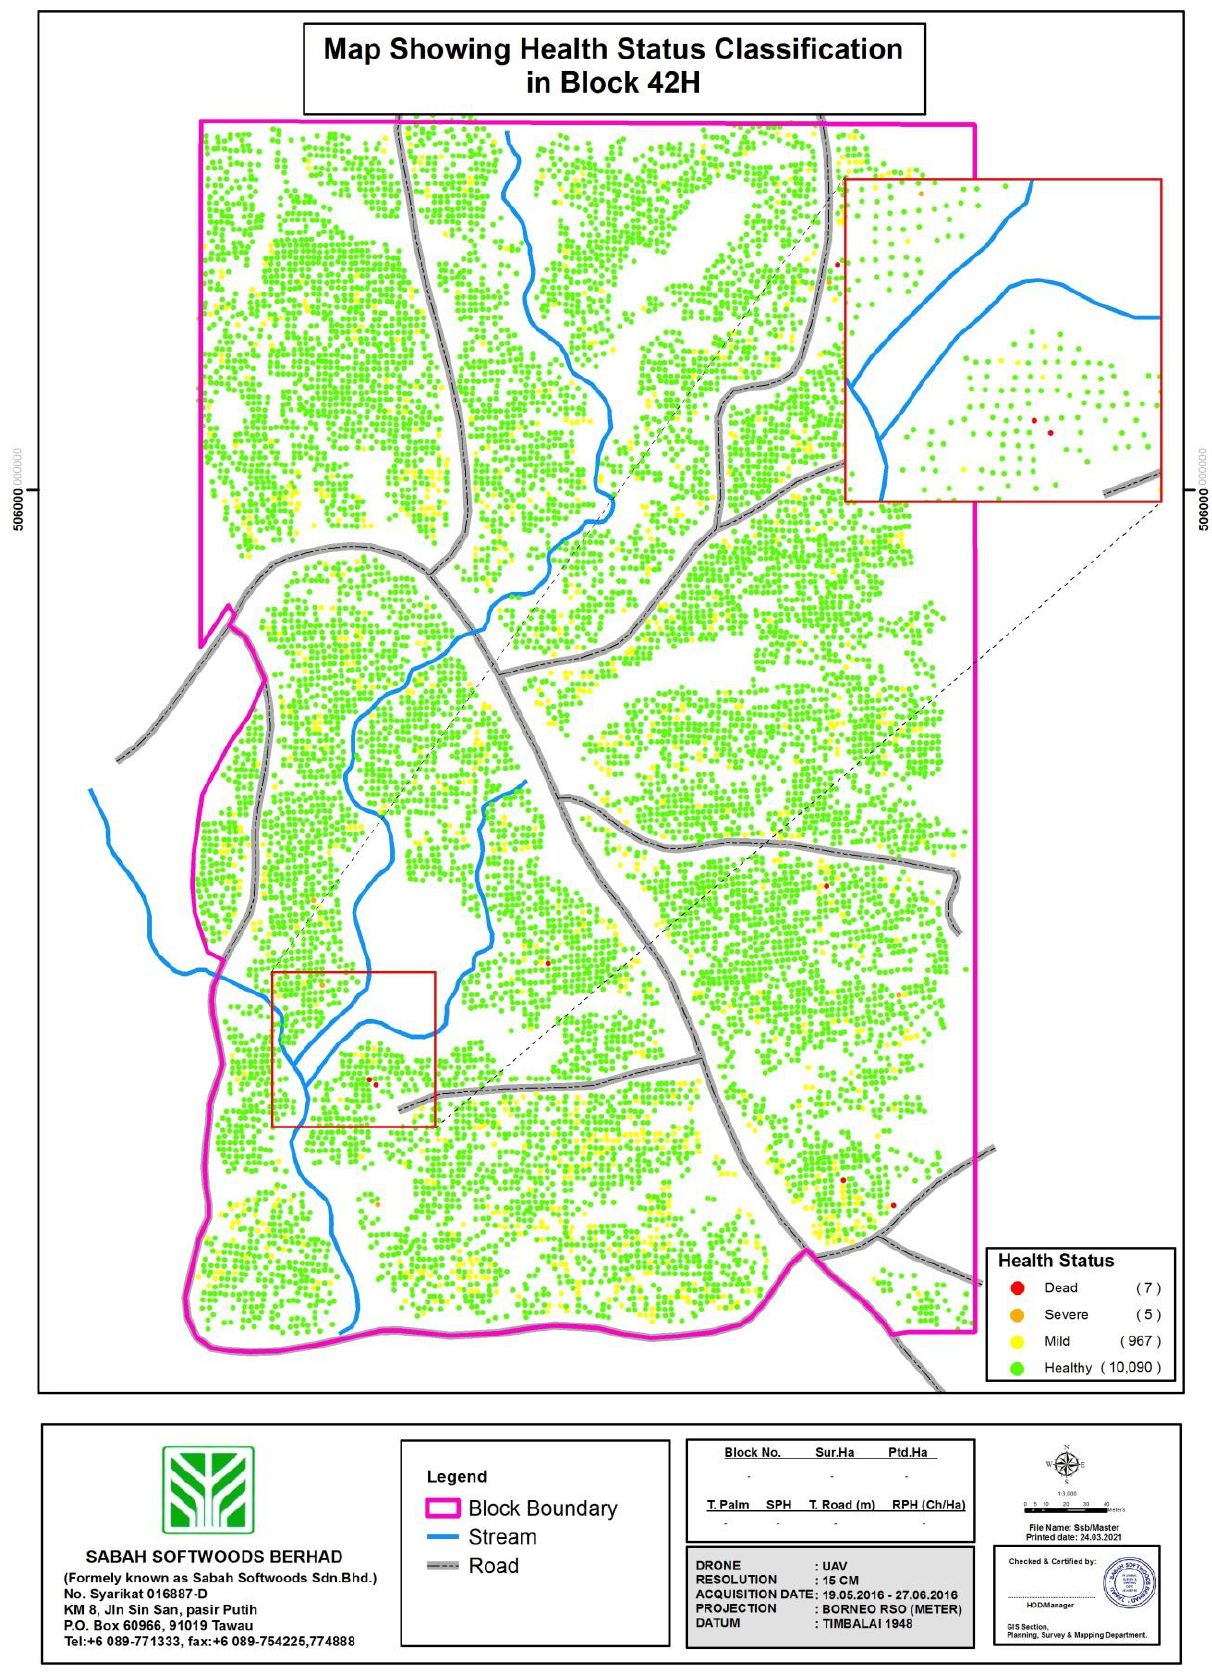
Figure 4. VARI-green result for Block 42H showing individual tree health status.